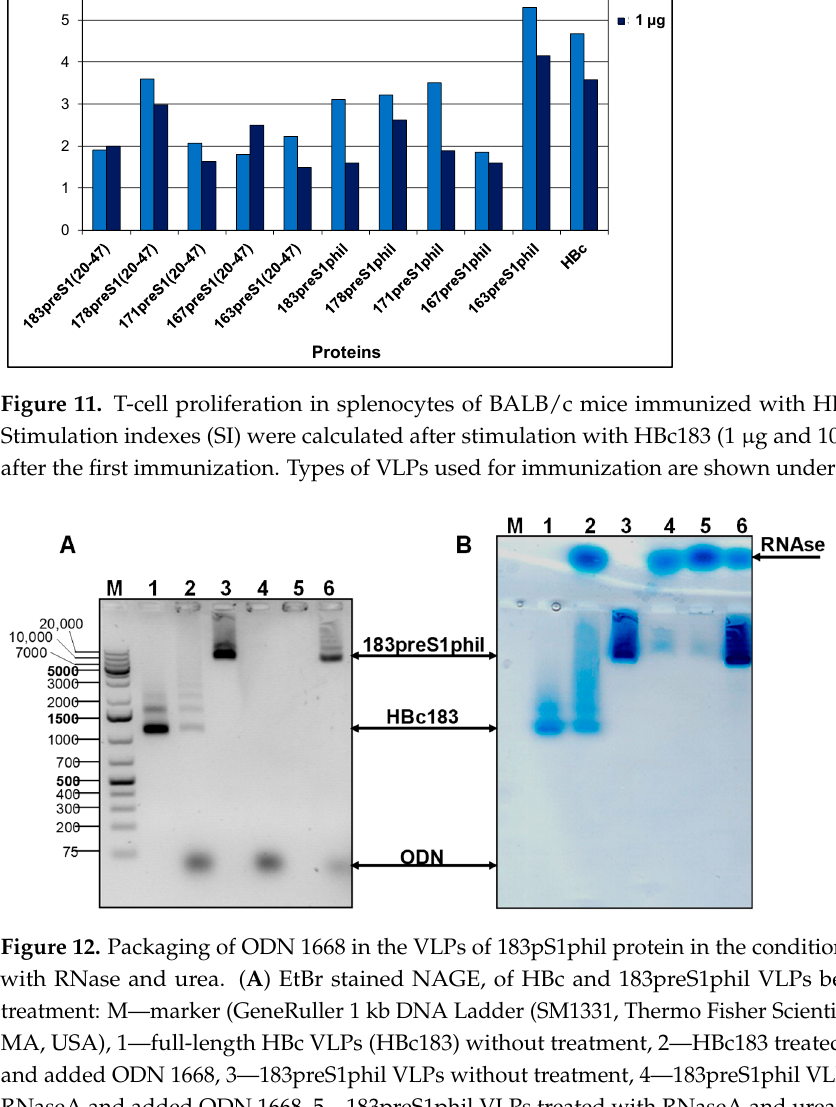
Figure 11. T-cell proliferation in splenocytes of BALB/c mice immunized with HBc-preS1 VLPs. Stimulation indexes (SI) were calculated after stimulation with HBc183 (1 µg and 10 µg) on day 42 after the first immunization. Types of VLPs used for immunization are shown under the bars.